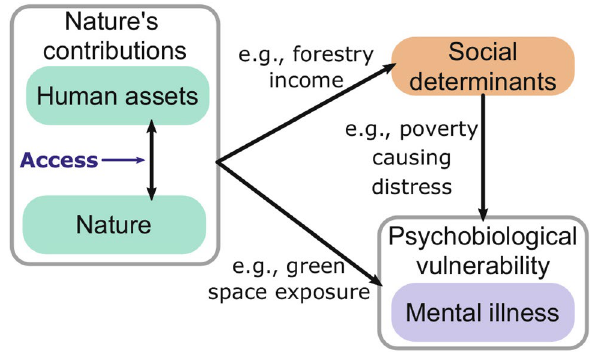
Figure 1. Illustrating how interactions between people and nature co-produce contributions that affect social determinants of mental illness, depending on an individual’s psychobiological vulnerabilities (adapted